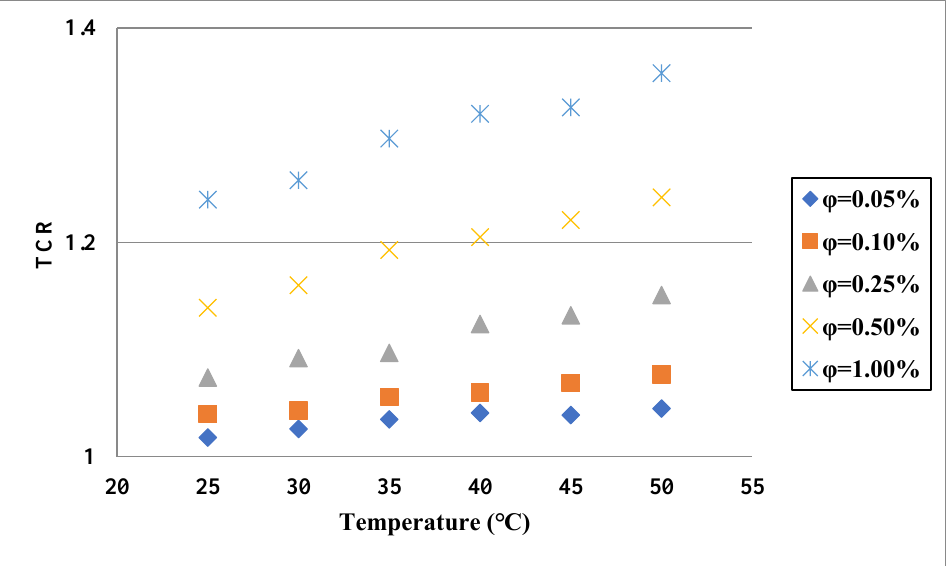
Figure 2. TCR and the enhancement in TC for different VFs. Adapted from Ref. [37].